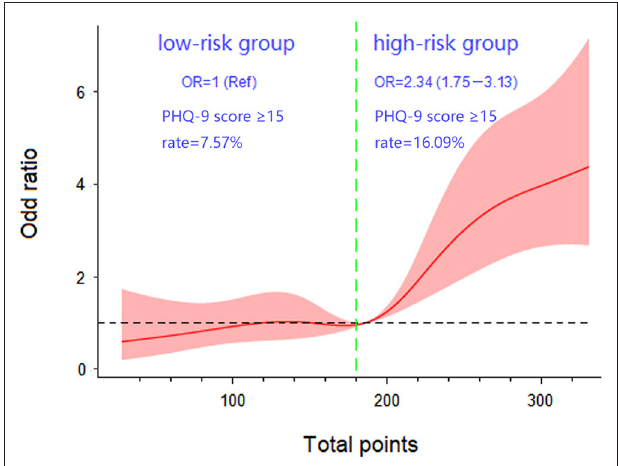
FIGURE 5 | Dose-response association between total points. The presence of major depression in patients with erectile dysfunction with five knots located at the 5th, 27.5th, 50th, 72.5th, and 95th percentiles. (Ref, reference; OR, odds ratio).